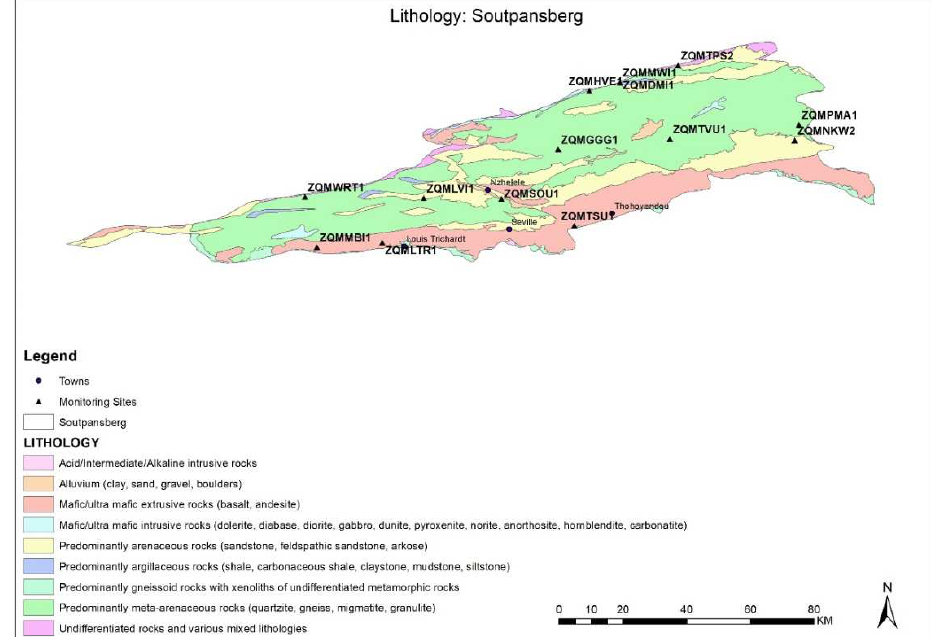
Figure 1. Locality map of the Soutpansberg region with the existing groundwater monitoring stations.